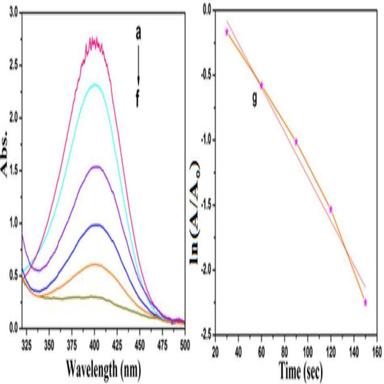
UV–visible spectrum of NiP taken at 30 s time interval in the presence of Cu-SA hierarchical structured catalyst and NaBH4 (a–f) and plot of time against ln(A/ Ao) (g).